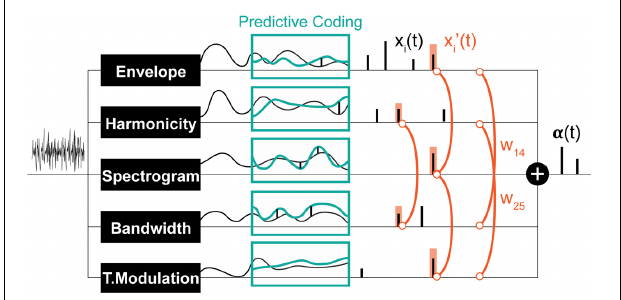
FIGURE 3 | Schematic of the computational saliency model. The model is structured along three stages. It starts with an acoustic waveform and extracts relevant features along five dimensions. Regularities within each feature dimension are then tracked used a Kalman-filter to make predictive inferences about deviations from ongoing statistics in that corresponding feature. Detected deviants are boosted according to interaction weights learned using the experimental stimuli, then integrated across feature dimensions to yield an overall saliency estimate of the entire auditory scene. The final values mark salient timings in the